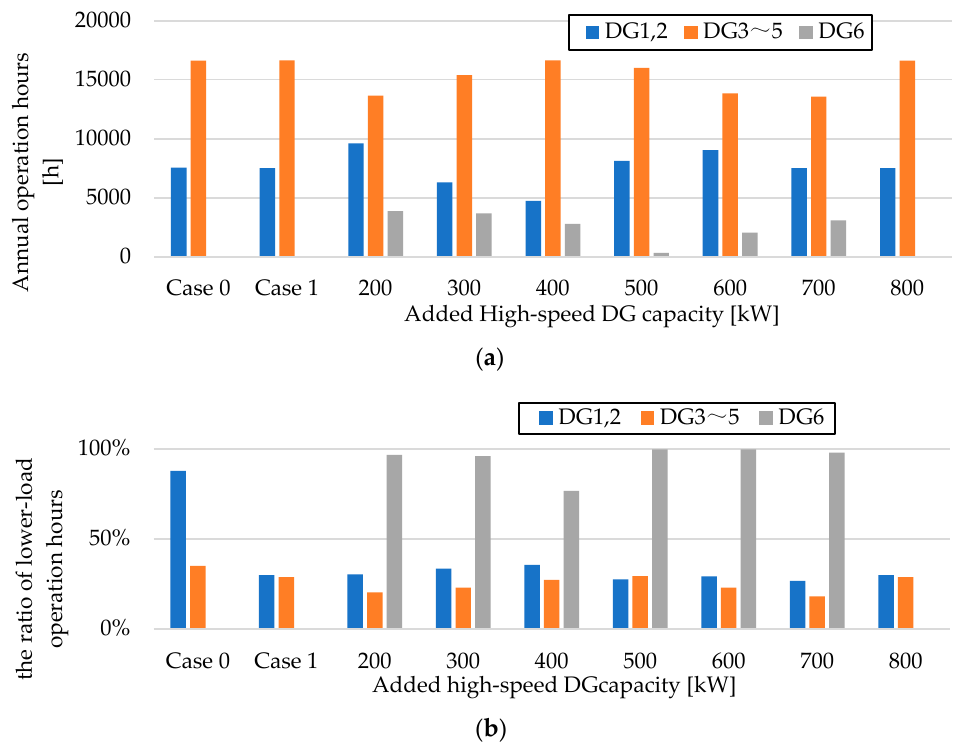
Figure 9. The annual operation hours and the ratio of low load operation hours of Case 0, Case 1, and Case 3: ( a ) Annual operation hours; ( b ) The ratio of low load operation hours for a load factor less than 50%.